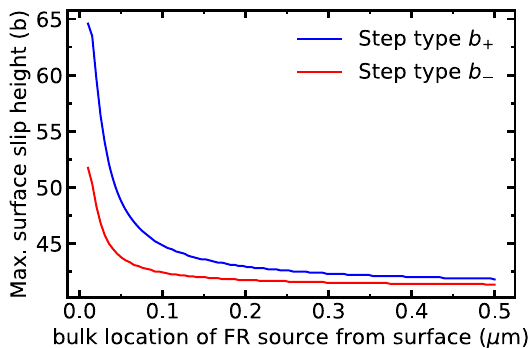
FIG. 7. Surface slip height enhancement due to emissions from FR sources located inside the bulk material under an E field of 10 GV = m and heating of 80